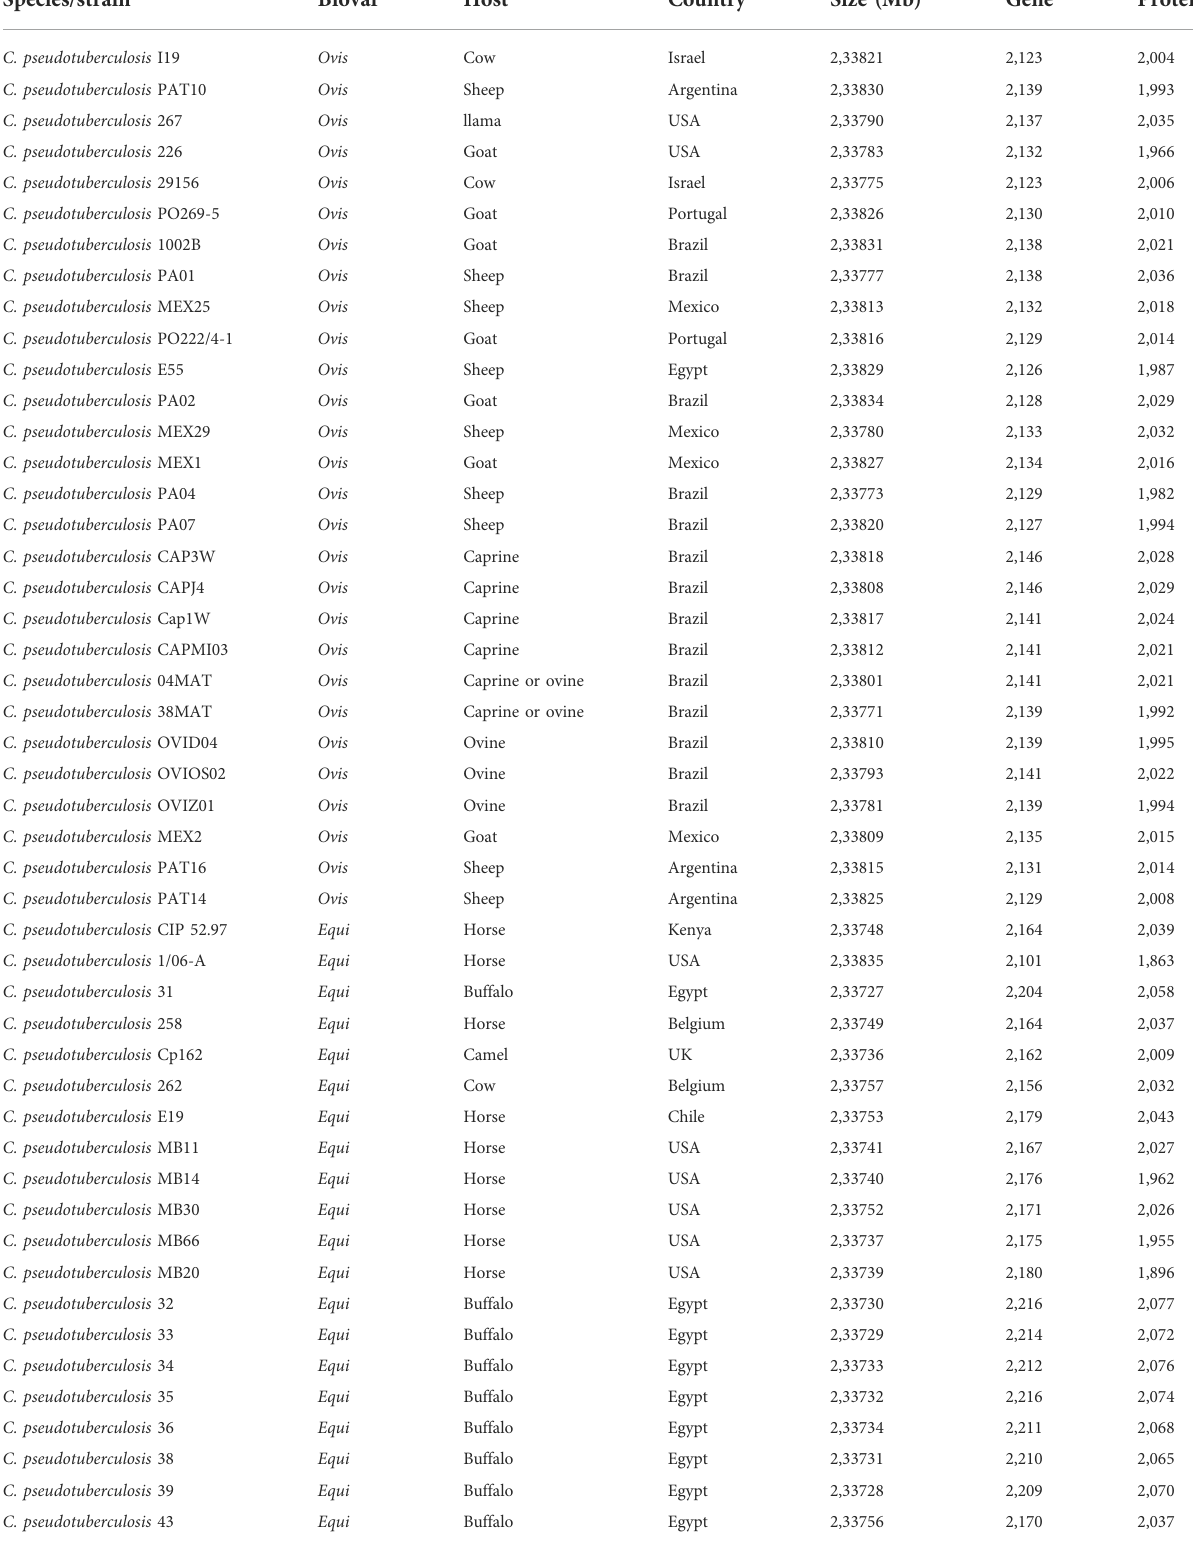
TABLE 1 General information on the genomic dataset of 54 genomes of Corynebacterium pseudotuberculosis used in this work.